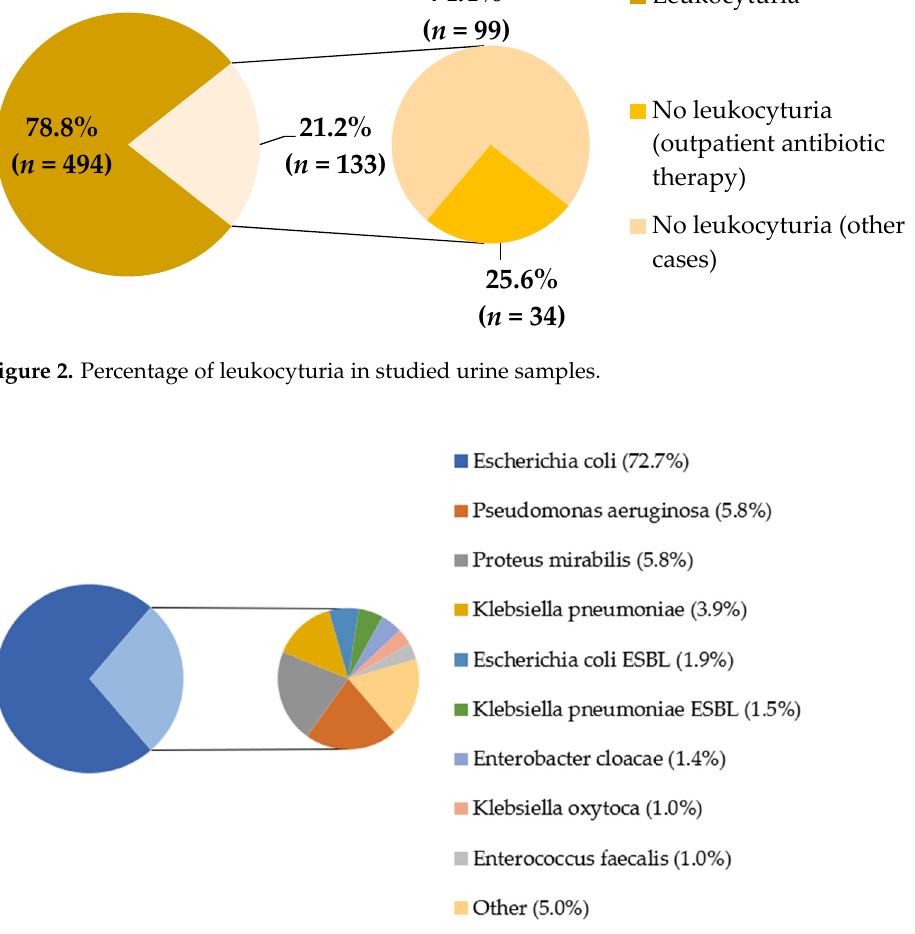
Figure 3. Percentage of bacterial strains in the urine cultures of patients; ESBL—extended-spectrum beta-lactamases. Other: Proteus vulgaris (0.68%), Citrobacter freundii (0.52%), Citrobacter koseri ,